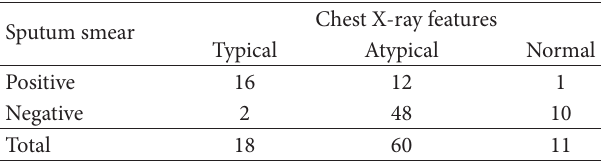
T 4: Relationship between sputum smear and chest X-ray